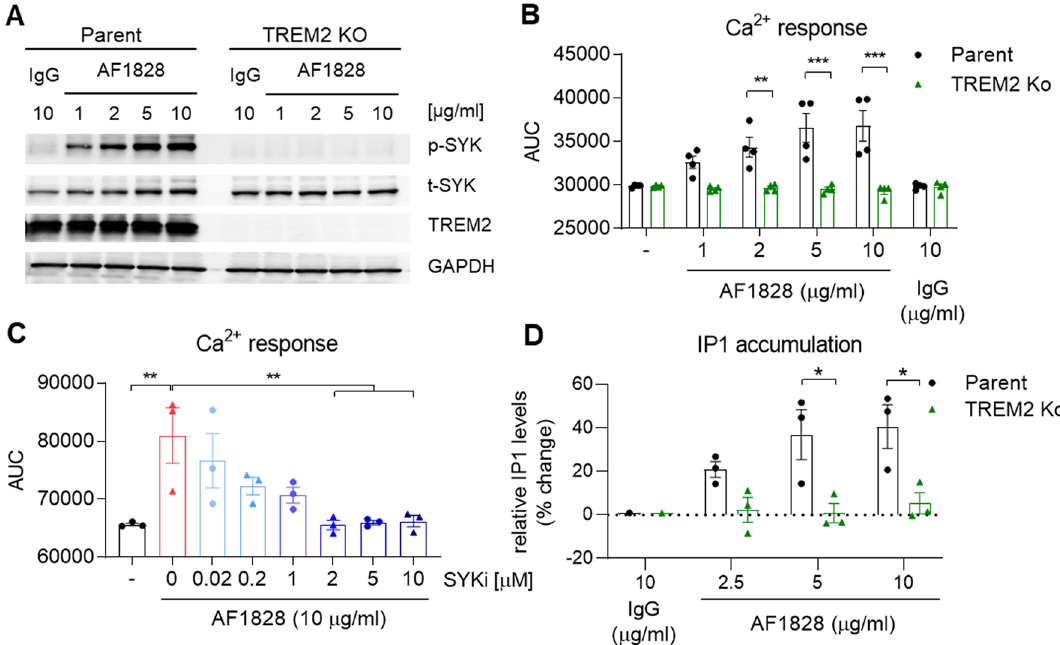
Figure 1. TREM2 agonism induces PLC activity in iPSC- derived macrophages. ( A ) Representative Western blot showing phosphorylation of SYK after TREM2 stimulation for 5 min using a TREM2-specific antibody (AF1828, R&D Systems) in Parent and TREM2 Ko cells. Full immunoblot images are presented in Supplementary Fig. 6. ( B ) Ca 2+ flux induced by TREM2 ligation in Parent cells is absent in TREM2 Ko cells. n = 4. ( C) SYK inhibitor BIIB-057 (SYKi) reduces TREM2 antibody-evoked Ca 2+ signal in a dose-dependent manner in Parent cells. n = 3. ( D) TREM2-induced IP1 accumulation determined by HTRF assay is prevented in TREM2 Ko cells. n = 3, data shown represent mean ± SEM, ( B , D ) two-way ANOVA followed by Bonferroni’s multiple comparison test, ( C ) one-way ANOVA followed by Bonferroni’s multiple comparison test, * p < 0.05, ** p < 0.01, *** p < (IP1), a stable downstream metabolite of IP3 generated by activation of PLC using an HTRF assay. We observed IP1 accumulation in Parent cells when stimulated with AF1828 in a concentration-dependent manner, while TREM2 Ko cells failed to accumulate IP1, further validating the lack of PLC response to AF1828 in the absence of TREM2 (Fig. 1D). To study the function of PLCγ2 in TREM2-mediated responses, homozygous PLCγ2 Ko iPSC lines were gen- erated in the wild-type BIONi010-C line. Three Ko clones were selected that showed no major genetic alterations determined by Illumina SNP microarray analysis (Suppl. Figure 1) and were validated for the absence of PLCγ2 protein by Western blotting (Suppl. Figure 2A). Parent and PLCγ2 Ko lines showed similar amounts of PLCG1 gene expression, as determined by RNAscope analysis, excluding the possibility that PLCγ1 is dysregulated to compensate for the absence of PLCγ2 (Suppl. Figure 2B). We analysed TREM2 expression in the PLCγ2 Ko clones and observed reduced TREM2 levels compared to Parent iPSC-macrophages, determined by Western blot (Fig. 2A, Suppl. Figure 2A). This finding has to be kept in mind as a lower abundance of TREM2 on the cell surface could account for changes in cell signalling and phenotype. The decrease in total TREM2 protein also results in a lower degree of TREM2 being shed from the membrane, evidenced by lower levels of soluble TREM2 detected in the supernatant (Fig. 2B). We validated macrophage identity after differentiation of the PLCγ2 Ko iPSC lines by detection of typical lineage markers by flow cytometry, which were expressed in all lines (Fig. 2C). The three PLCγ2 Ko clones however showed lower surface expression of CD11b, while CD14 levels were clearly increased, possibly indicating differences in basal cell activation in the absence of PLCγ2. iPSC-macrophages differentiated from PLCγ2 Ko clones also demonstrated differences in morphology, signified by higher cell roundness and smaller cell area (Fig. 2D). The finding that baseline expression of several macrophage surface markers as well as cell morphology are distinctly altered in PLCγ2 Ko cells points to fundamental differences in cells differentiated in the absence of PLCγ2 that could lead to altered functional effects observed in the Ko lines. As we found similar responses of the three clones in all assays we conducted, we hereafter show representative data from clone 20 when not otherwise stated. We next assessed TREM2 signalling in the PLCγ2 Ko iPSC-macrophages following stimulation with the anti- TREM2 polyclonal antibody AF1828 and observed a similar degree of SYK phosphorylation by Western blot as seen in the Parent line (Fig. 3A, B), indicating that signalling upstream of PLCγ2 was not affected, at least when a strong activator such as the polyclonal antibody is applied. We confirmed SYK phosphorylation using HTRF technology, a sensitive assay that enables the detection of small changes more reliably than Western blot. Again, SYK phosphorylation in PLCγ2 Ko cells was not significantly reduced upon stimulation with AF1828 (Fig. 3C). Although SYK phosphorylation upstream of PLCγ2 was normal, the calcium response upon TREM2 ligation